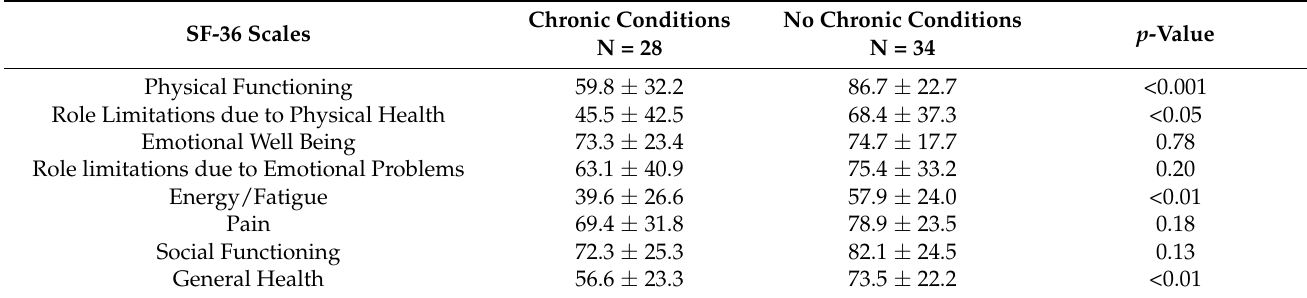
Table 5. Comparison of SF-36 scores between adults with and without pre-existing chronic